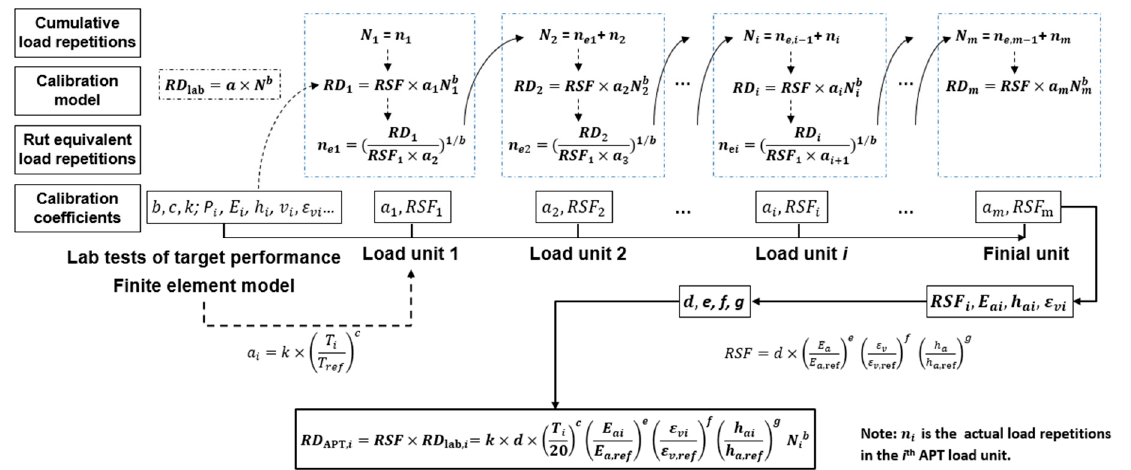
Figure 8. Calibration method and process of the rut depth prediction model, based on the full- scale APT.